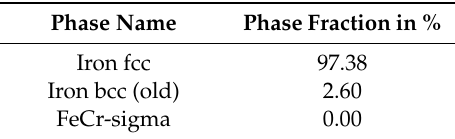
Figure 13. Electron backscatter diffraction (EBSD) mapping at the layer transition zone. Table 8. Identified tabled phase fractions.